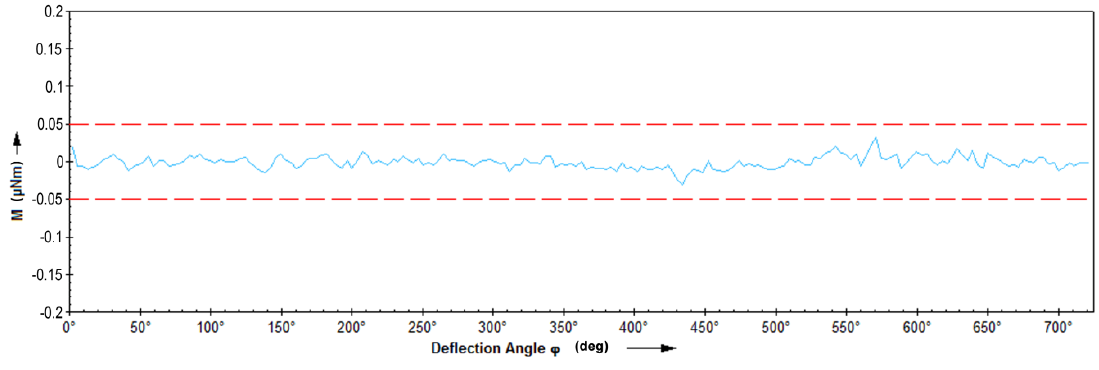
Figure 4. Air test chart.